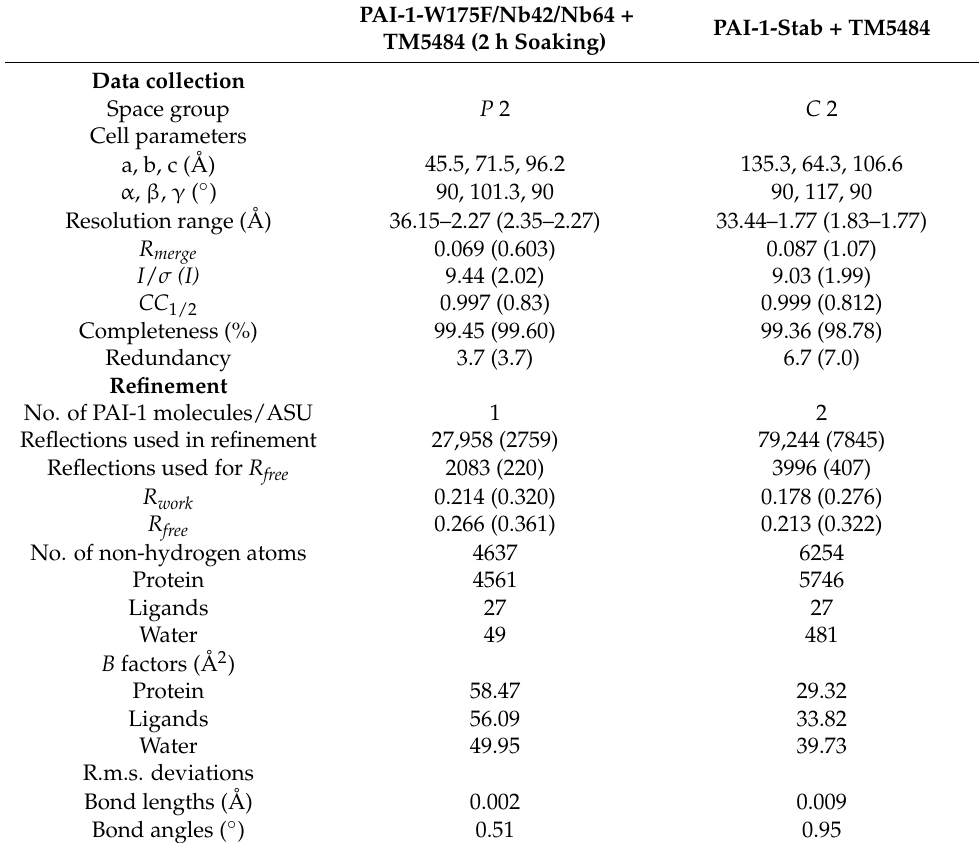
Table 1. Data collection and refinement